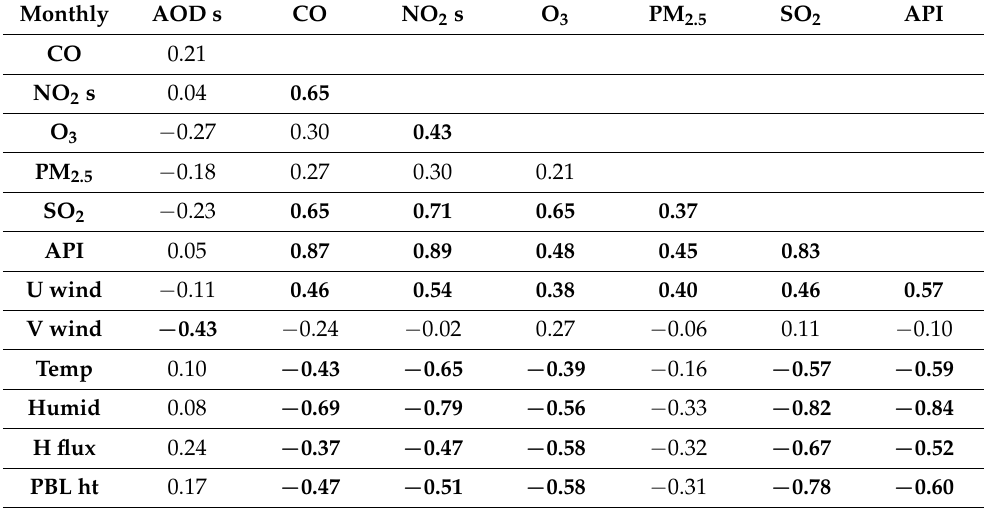
Table 2. Simultaneous pair-wise cross-correlation of surface air constituents and ERA5 1000–850 hPa meteorology variables over the Durban-area: monthly (2001–2020 N =